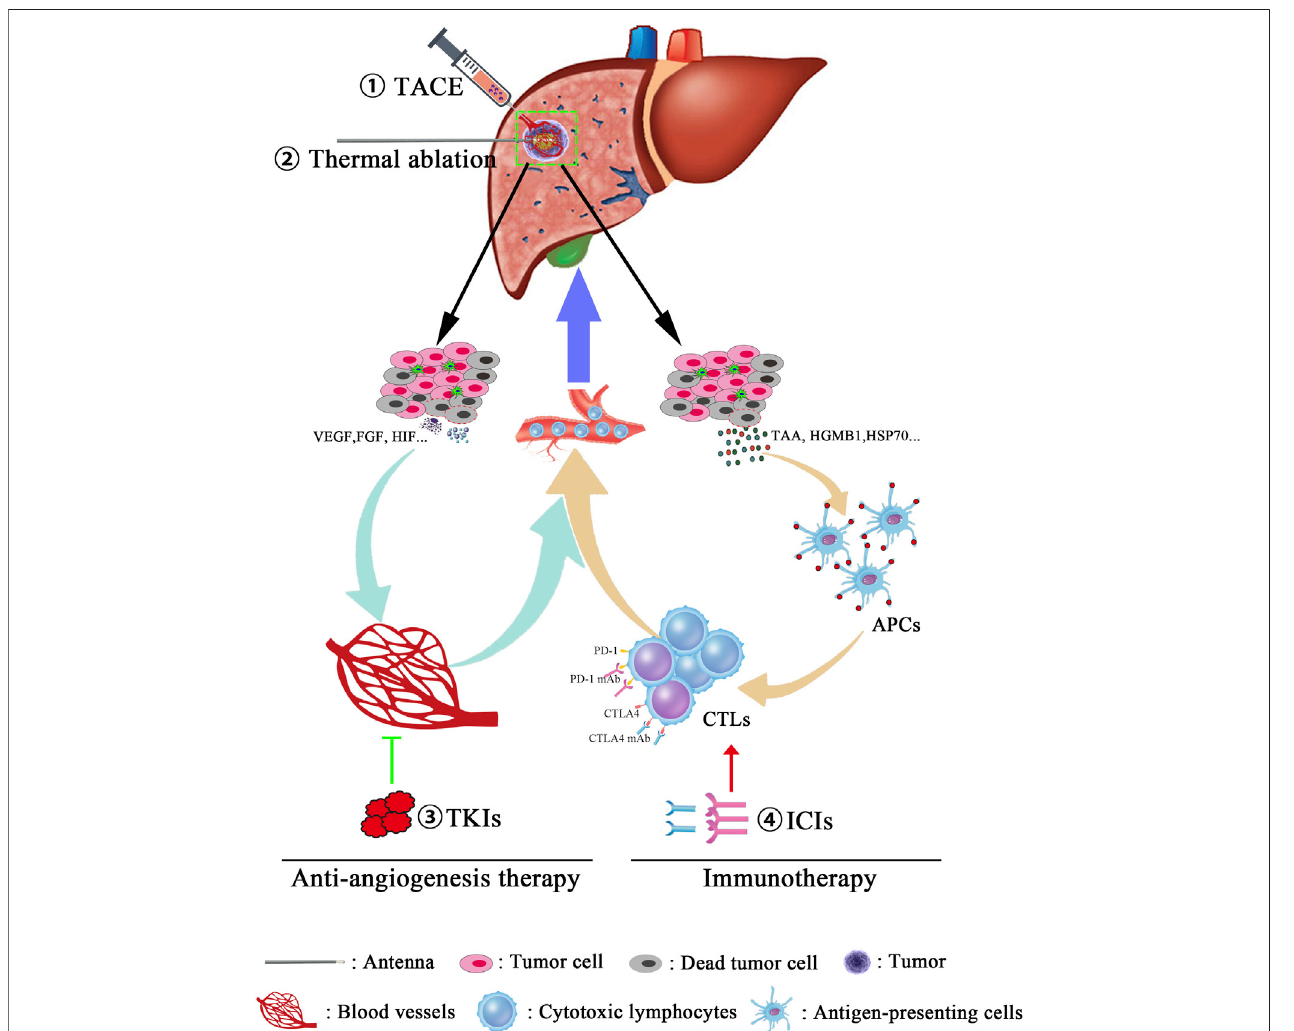
FIGURE 1 | Combination therapies for the treatment of advanced hepatocellular carcinoma. Multitreatment modalities were used for managing tumor progress, and the detailed procedures are also described as follows: First, for the purpose of tumor burden reduction, the cancerous blood supply was obstructed using transcatheter arterial chemoembolization (TACE).Then, microwave ablation will further promote the tumor destruction in a manner of inducing an irreversible heat injury. Third, due to the necrosis and apoptosis of cancer cells, tumor-associated antigens (TAAs) and some cytokines such as VEGF, HIF, and FGF will be released into circulation, following an acute antitumor immune reaction and proangiogenic effects, respectively. Finally, immune checkpoint inhibitors (anti-PD1 mAb and anti-CTLA4 mAb) were used in order to remove the inhibition of antitumor effects and enhance the tumor-killing ability of CTLs. Moreover, antiangiogenesis therapy restrains the formation of blood vessels and leads to vascular normalization, which, in turn, synergically increases the in fi ltrated frequency of CTLs in tumor lesions.